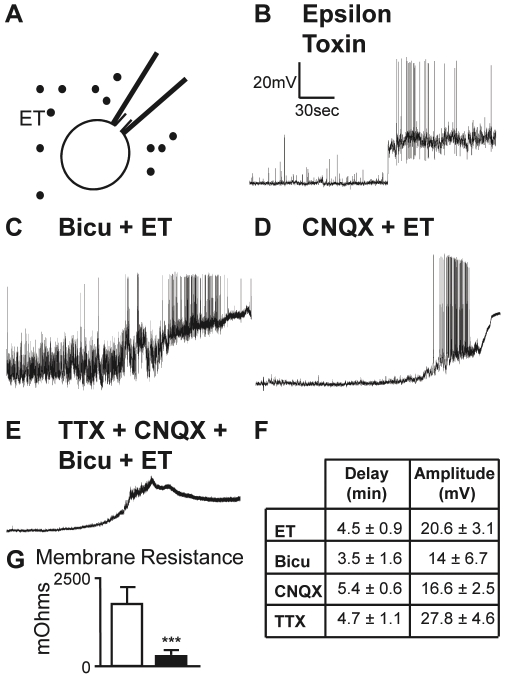
ET depolarizes granule cells in cultured slices.A, Schematic representation of the recording configuration (Whole Cell). B–E, typical membrane potential changes recorded in granule cells (using the Current Clamp mode) adjusted at −60 mV, after application of 10−7 M ET but without (B, n = 15) or after pre-treatment for 10 min with (C, n = 6) Bicuculline (Bicu, 10−5 M), (D, n = 7) CNQX (10−5 M) or, (E, n = 8) a cocktail of Bicuculline (10−5 M), CNQX (10−5 M) and TTX (10−6 M). F, quantification of the delay and amplitude of the depolarization induced by ET. For the corresponding n, see above. All comparisons vs ET alone are n.s. G, Changes in membrane resistance of the granule cells before (white bar) and 5 min after 10−7 M ET (black bar) (n = 15, p<0.001). Same scale for all voltage traces.